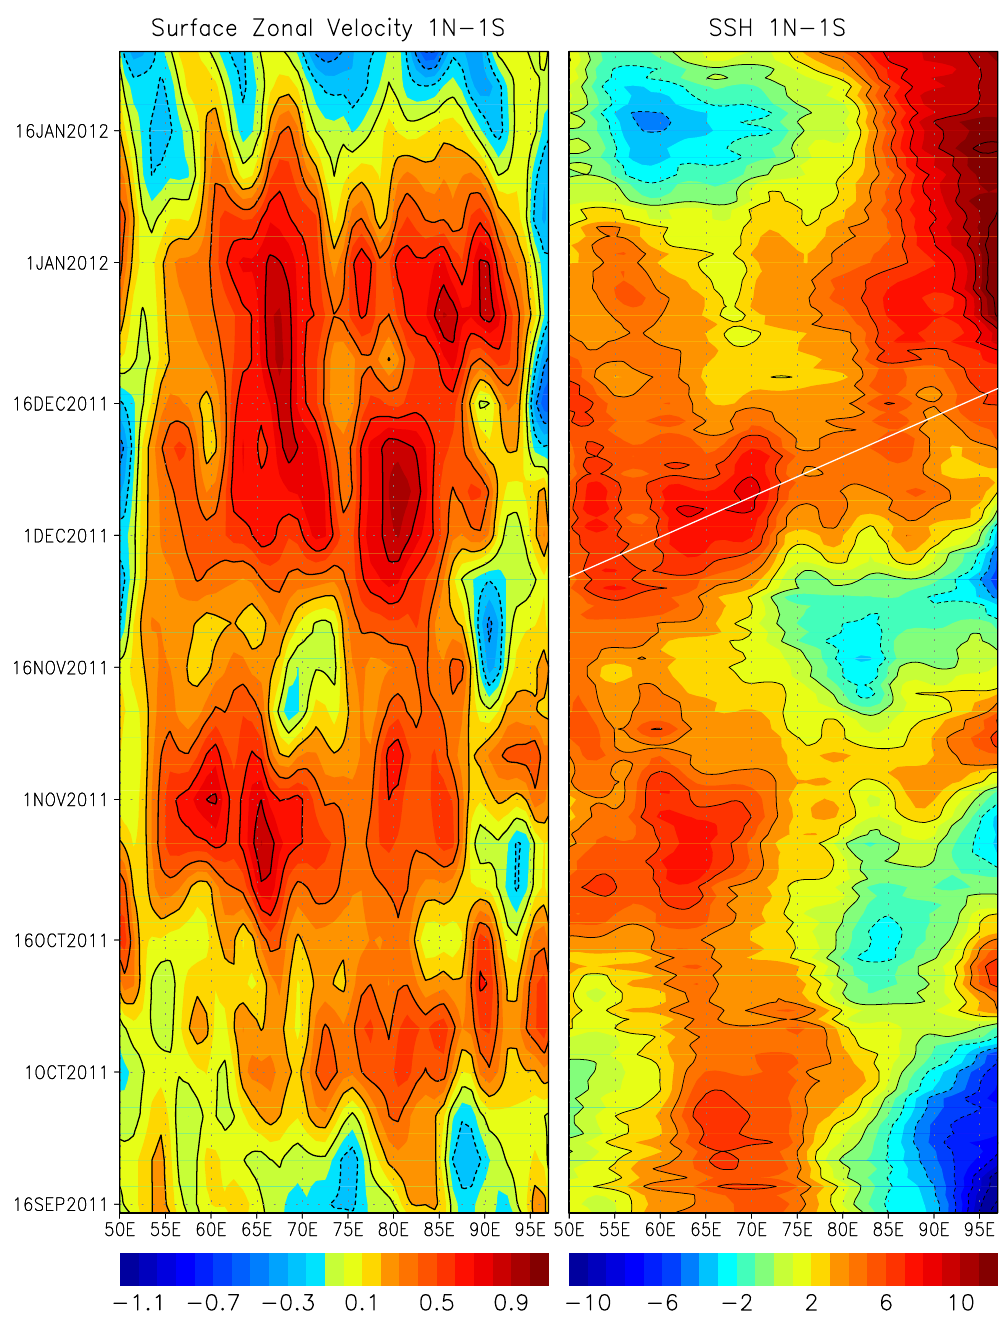
Figure 5. ( Left ): Longitude-time diagram of near surface zonal velocity (m/s) averaged over 1°N–1°S from OSCAR. ( Right ) Same as left panel except for sea surface height (SSH) anomaly (cm) derived from altimeter measurements. The white line indicates the phase speed of 2.8